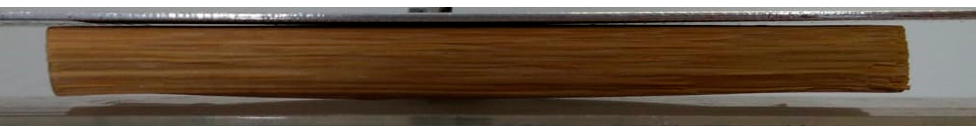
Figure 16. Bamboo sample densified with 20% MC.